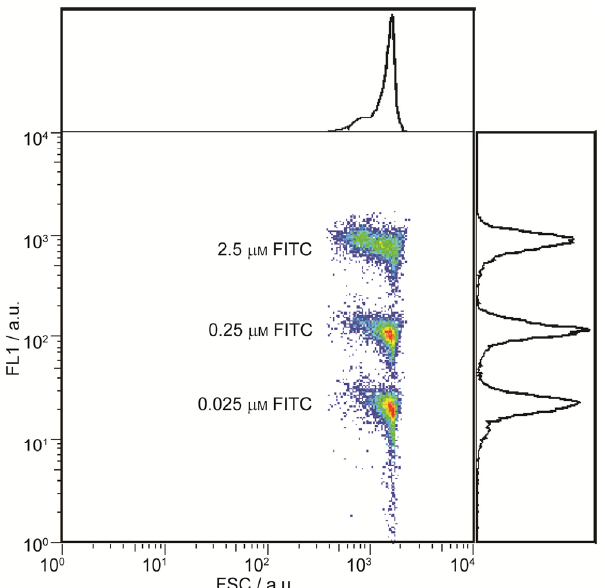
Figure 5. Flow cytometry analysis of a w/o/w double emulsion droplet mixture, containing three droplet species with different FITC contents. The three populations with varying FL1 values, present in the gated FSC vs. FL1 log-log dot-plot, refer to these species. Semi-log well-separated FL1